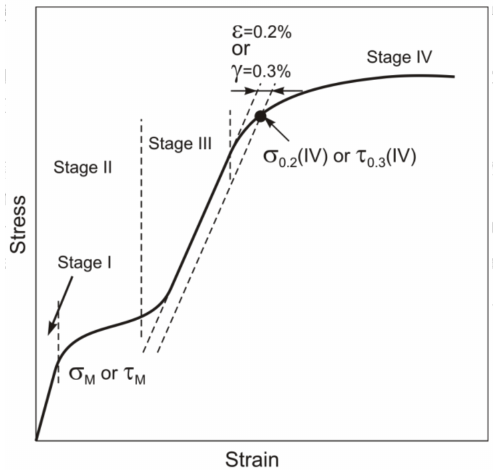
Figure 1. Schematic stress–strain diagram with stages I–IV at temperatures T d < M d for alloys with martensitic transformations: σ M , τ M : martensitic shear stresses; σ 0.2 (IV), τ 0.3 (IV): critical stresses are equal to yield stress σ 0.2 , τ 0.3 (according to